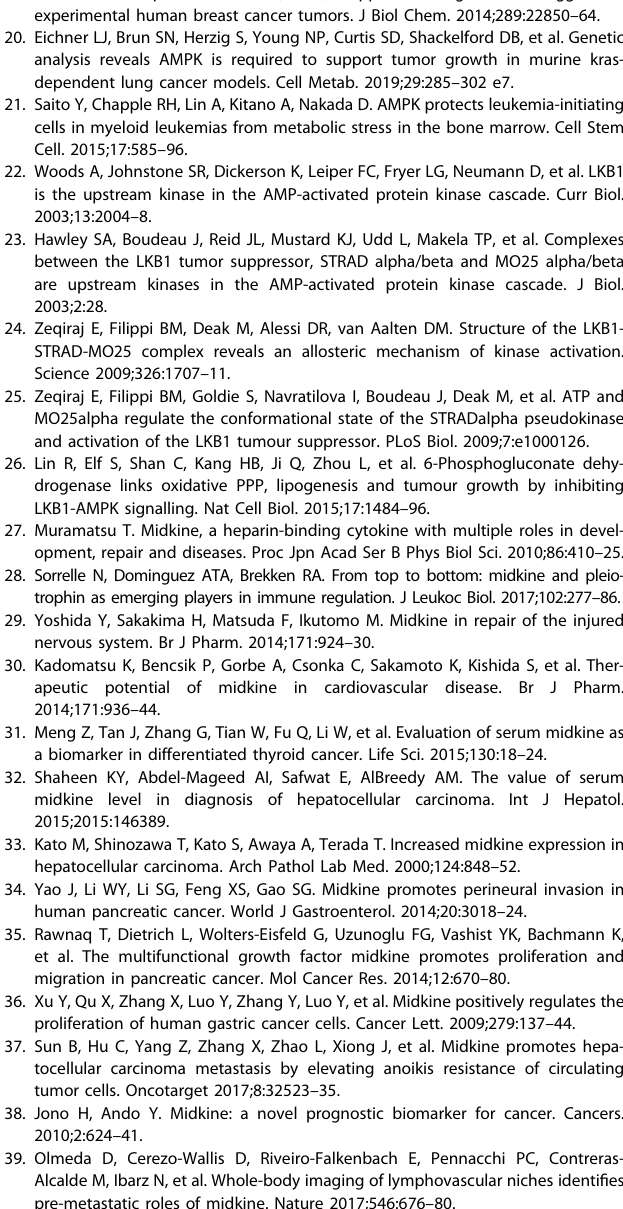
Fig. 7 Midkine promotes cancer progression by negatively regulating AMPK signaling. a Western blotting of MDK, LKB1 and β -actin from HCCLM3 cells transduced with LKB1 shRNA or in combination with MDK shRNA. b – c Colony-forming assay of the HCCLM3 cells transduced with LKB1 shRNA or in combination with MDK shRNA. Images ( b ) and quanti fi cation ( c ) of colony formation. n = 3 wells per group. Scale bar, 200 μ m. d GSEA results showing the negative correlations between MDK and the AMPK signaling pathway based on the TCGA LIHC and KIRC cohorts. Genes in the RNA-seq data were ranked by the Pearson coef fi cients of the correlations between the genes and MDK , and the ranked gene list was utilized as the input for the GSEA software program. e – f Scatter plots showing the inverse correlation of MDK with p-AMPK α expression and MDK expression in human hepatocellular carcinoma tumors ( e ), Kaplan – Meier survival curves of HCC patients with data strati fi ed by MDK expression levels ( f ) ( n = 74). g Scatter plots showing the inverse correlation of MDK AMPK activity in the TCGA LIHC and KIRC cohorts (LIHC n = 371, KIRC n = 531). Gene expression was obtained from RNA-seq data from the TCGA. AMPK activity was estimated by the expression of their downstream target genes. Statistical signi fi cance in (e-g) was determined by Pearson correlation test. R: Pearson correlation coef fi cient. R, Spearman rank correlation coef fi cient. h Kaplan – Meier survival curves of the TCGA KIRC patients with data strati fi ed by the expression of MDK and the activity of AMPK. HL: MDK is high, AMPK activity is low ; LH: MDK is low, AMPK activity is high. Median expression/activity levels were utilized as the thresholds for high and low separation. i . Schematic illustration of the MDK mechanisms of action: high MDK expression depolymerizes the LKB1-STRAD-Mo25 complex and subsequently suppresses the activity of AMPK signaling in human